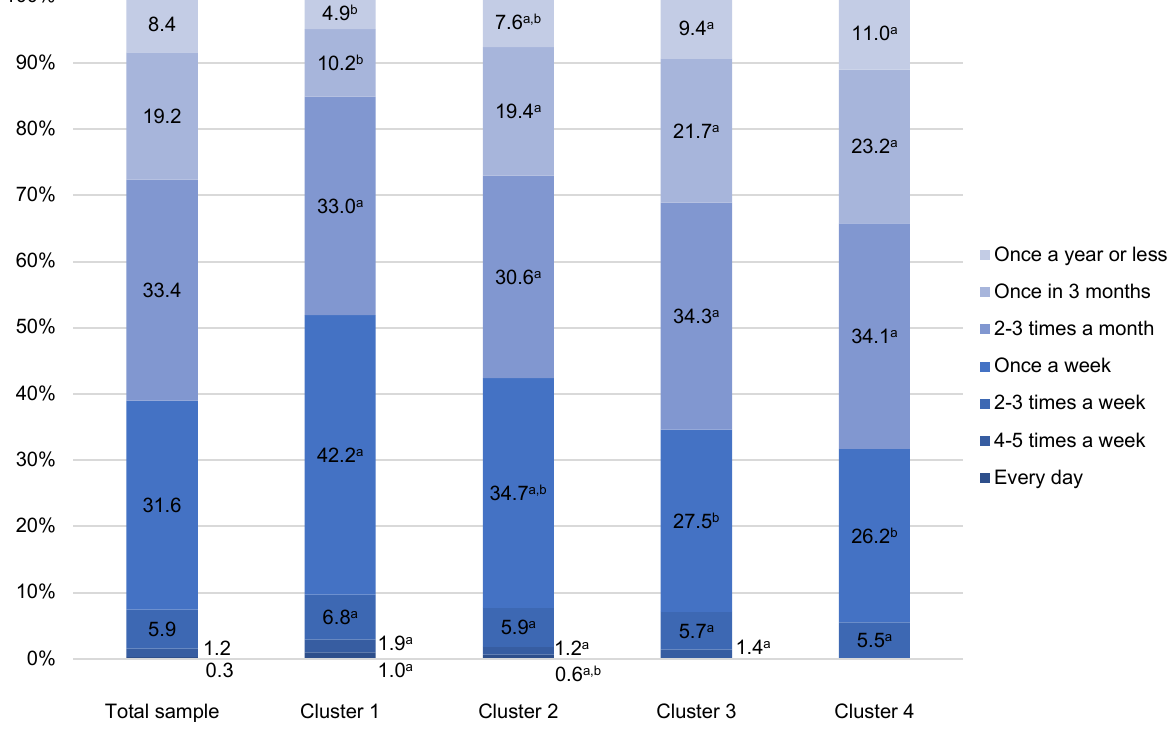
Figure 2. At-home fatty fish consumption of Croatian fishery consumers (n = 977). a,b Different letters in the same consumption frequency category indicate statistically significant differences ( p = 0.005).